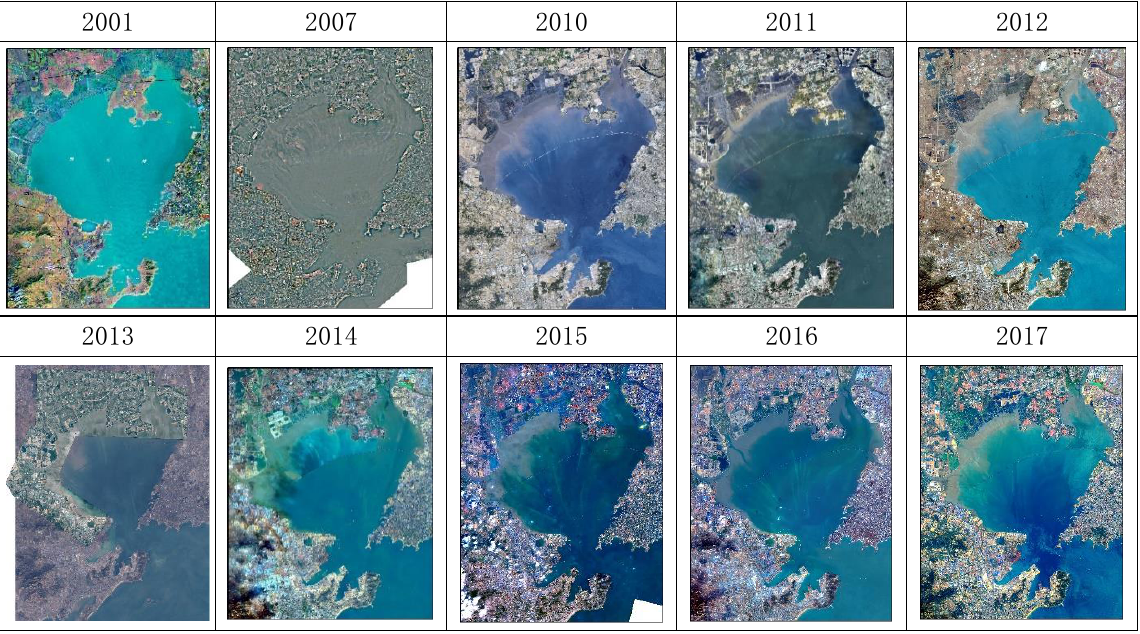
Figure 2 Remote sensing images of Jiaozhou Bay from 2001 to